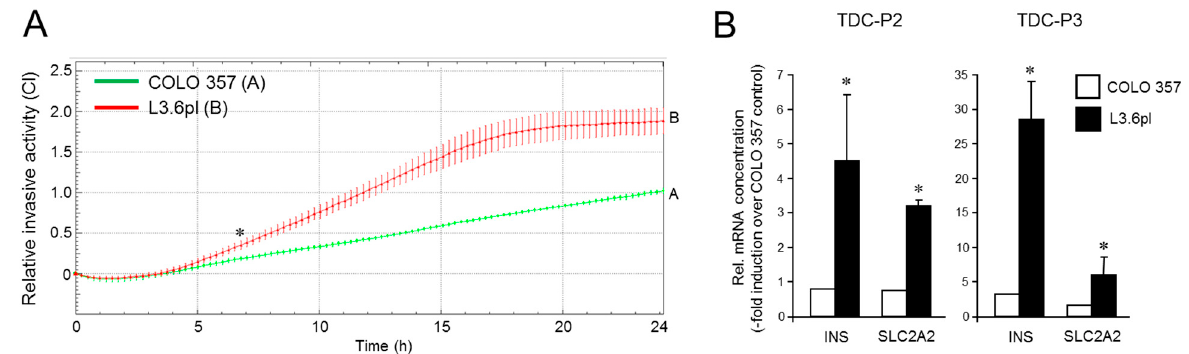
Figure 5. Comparison of the invasive and β cell TD potential of COLO 357 and L3.6pl cells. ( A ) Real-time cell migration assay with COLO 357 and L3.6pl cells. Data are the mean ± SD of quadruplicate wells and are significantly different between cell lines at 6:45 (denoted by an asterisk) and all later time points. The assay shown is representative of three independent RTCA assays. ( B ) COLO 357 and L3.6pl cells were cultured with P2 (TDC-P2), or a combination of IGF-1, SCF and transferrin (TDC-P3), for 72 h and assayed for INS and SLC2A2 mRNA abundance by qPCR. The data shown are from a representative experiment out of three experiments performed in total (mean ± SD of triplicate wells). Displayed are the values for TDC in relation to those of COLO 357 cells with control medium. The asterisks ( ∗ ) denote significance ( p < 0.05, unpaired two-tailed Student’s t test). The changes in INS and SLC2A2 RNA expression between COLO 357 cells treated with either TDC-2 or TDC-3 and the respective untreated controls were also significant (not shown for reasons of clarity).